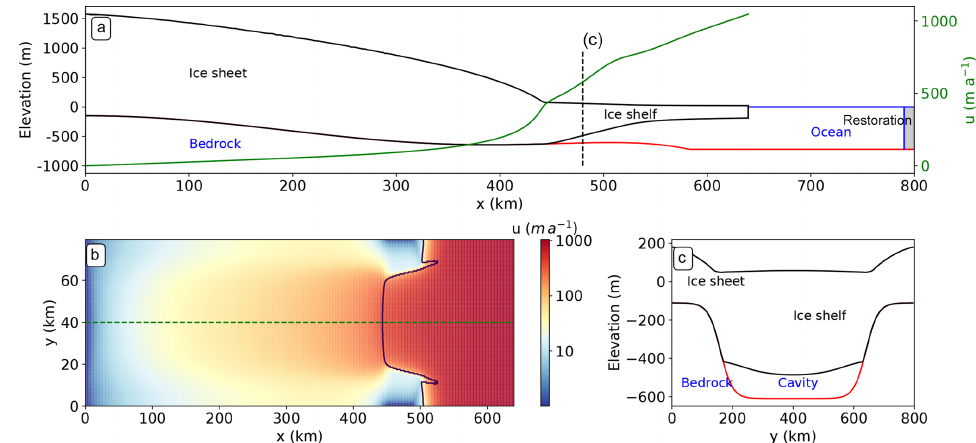
Figure 2. Initial ice-sheet in equilibrium calculated by Elmer/Ice with an accumulation rate of 0.3ma − 1 and no sub-shelf melting as required by the MISMIP + protocol (Asay-Davis et al., 2016). (a) Side-view geometry in the central flow line, also indicating the position of the ocean restoration used by the ocean model, and the velocity magnitude along the central flow line shown in panel (b) . (b) Velocity magnitude seen from above. The black solid line indicates the grounding line. (c) Cross section of the ice sheet at x =